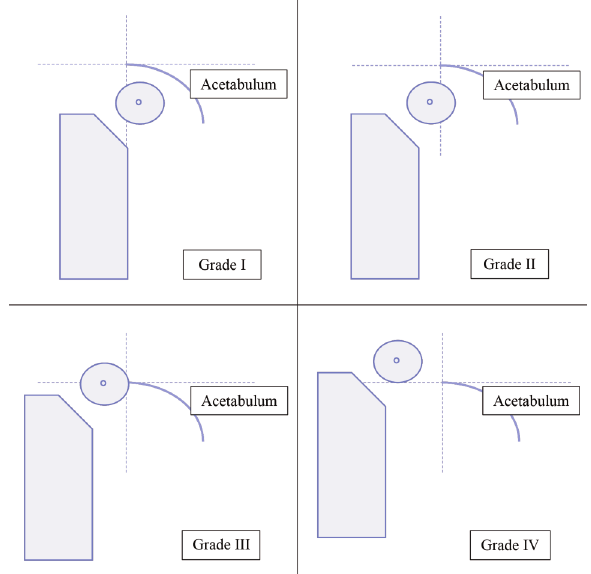
Schematic grading of DDH Severity based on the Tonnis Fig. 1: classification.